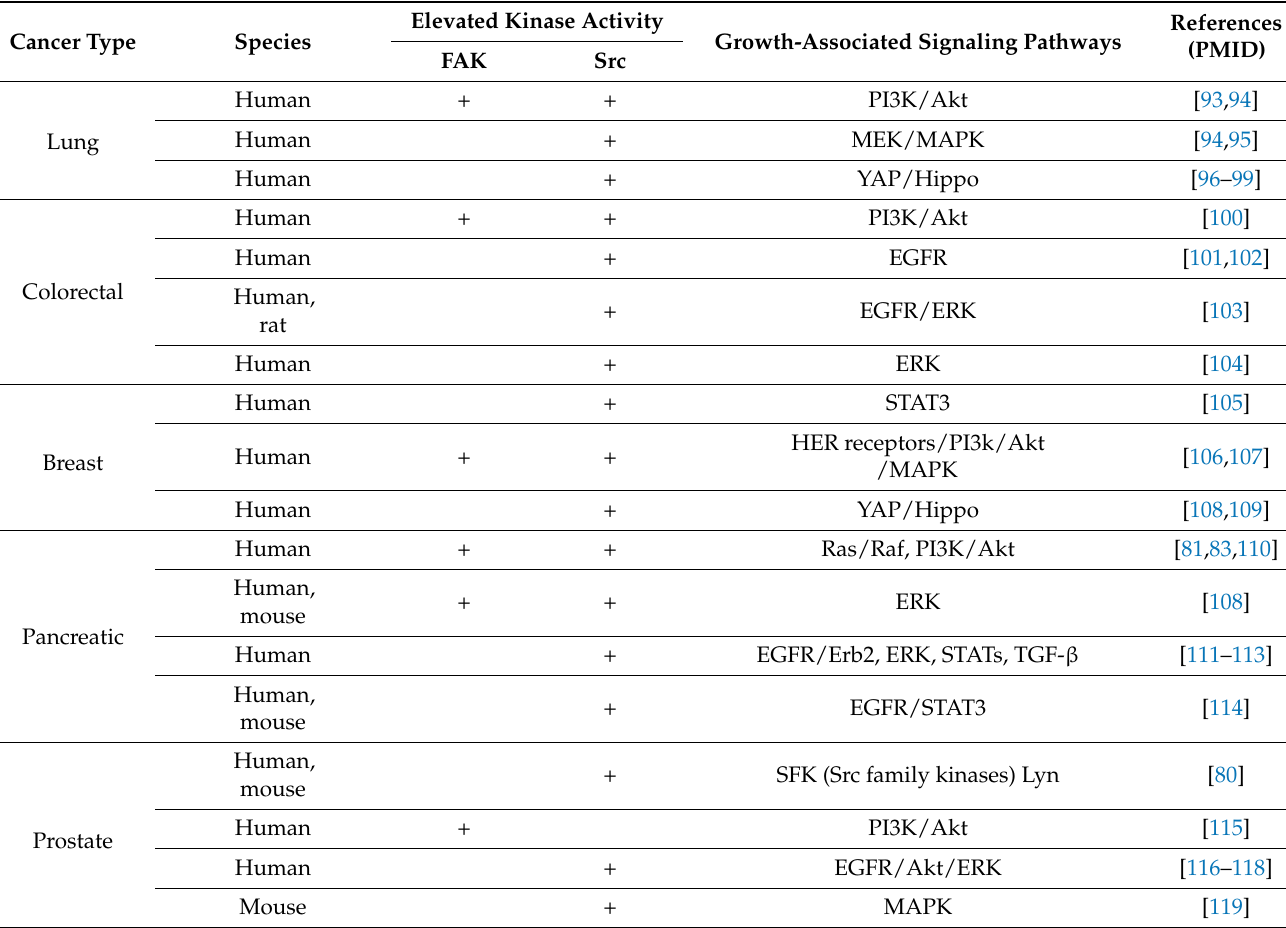
Table 1. Major growth-associated FAK and/or Src signaling pathways in the top 5 deadliest cancers according to the American Cancer